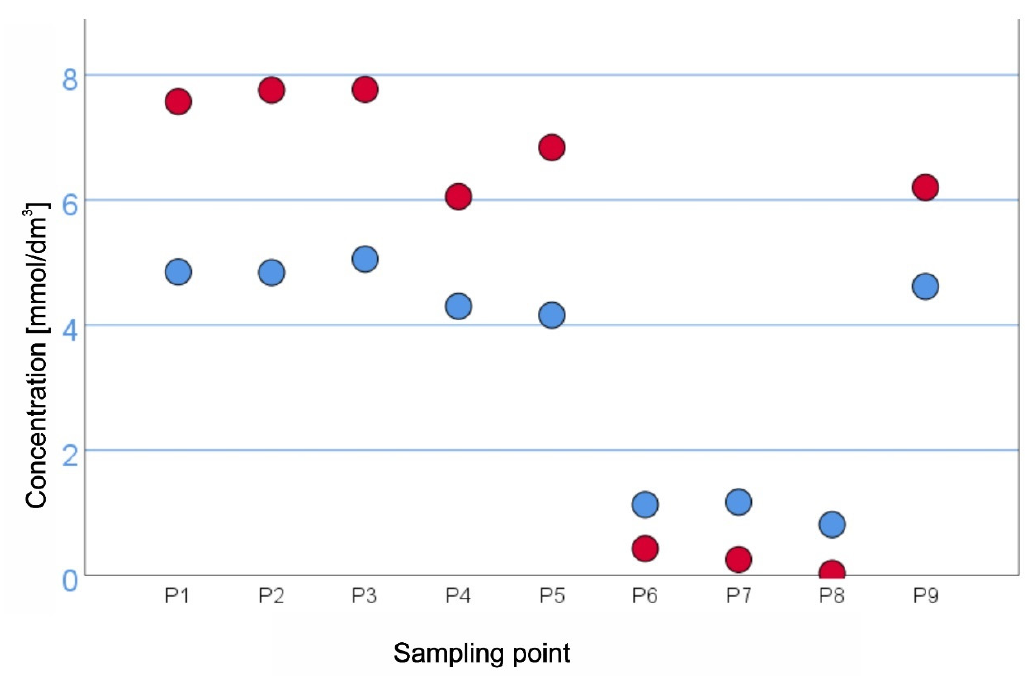
Figure 8. Concentration of Ca 2+ (blue points) and SO 42 − (red points) in sampling points [mmol/dm 3 ].